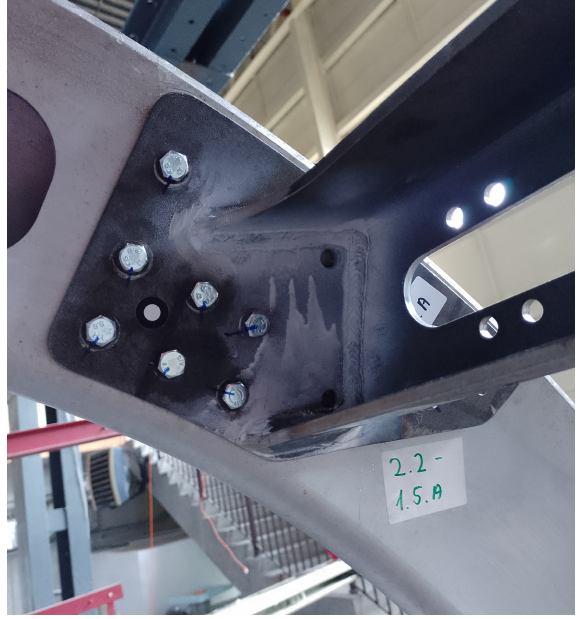
Figure 8. Bolt and screws